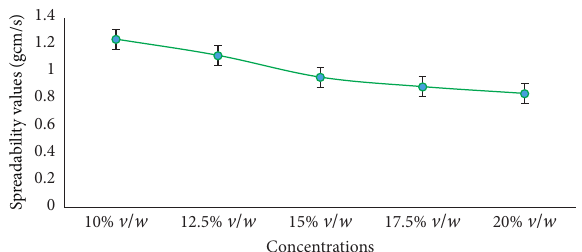
Figure 3: Spreadability studies of the neem seed oil cream at their various concentrations.